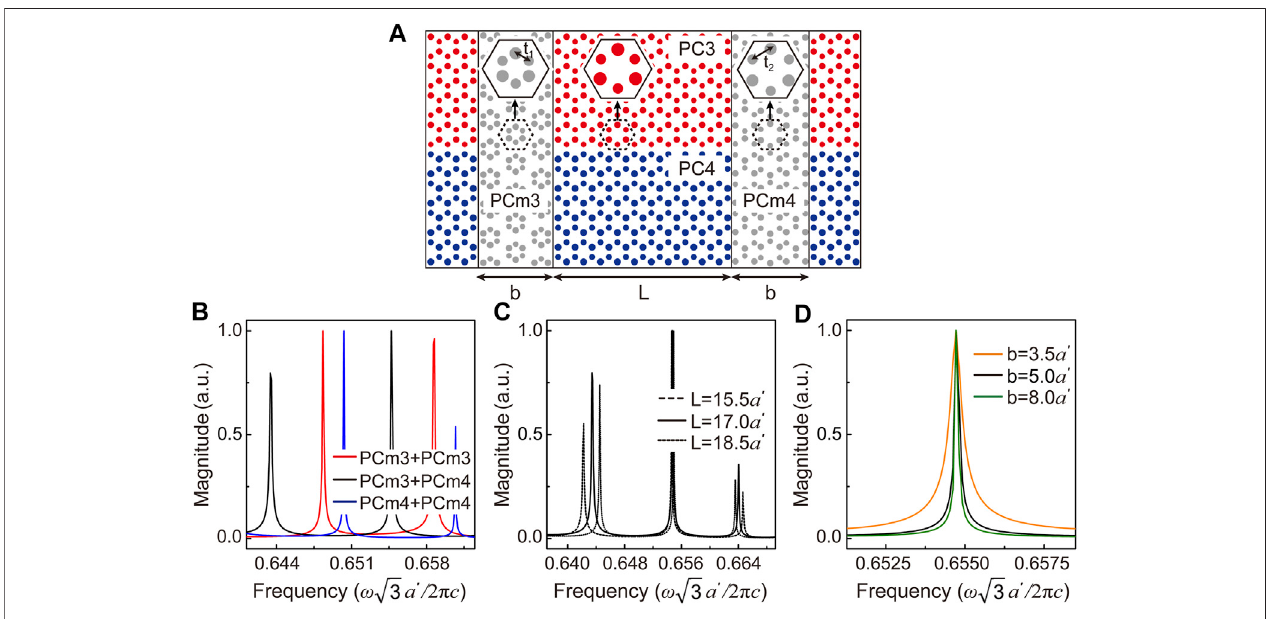
FIGURE 5 | (A) Schematics of OTC type II and 2 PC cavity mirrors. PCm3 (PCm4) is considered with a shrunken (expanded) lattice compared to the PC structure consideredattheinterfaceregion. (B) ThemodeselectionofdifferentPCmirrorcon fi gurations. (C) Thereceivedtransmissionspectrawithdifferentcavitylengths. (D) By tuning the thickness of PC mirrors, the cavity fi delity will be enhanced ( b (cid:1) 3 . 5 a ’ , Q (cid:1) 1333 . 20; b (cid:1) 5 a ’ , Q (cid:1) 3418 . 46; and b (cid:1) 8 a ’ , Q (cid:1) 4830 . 43).